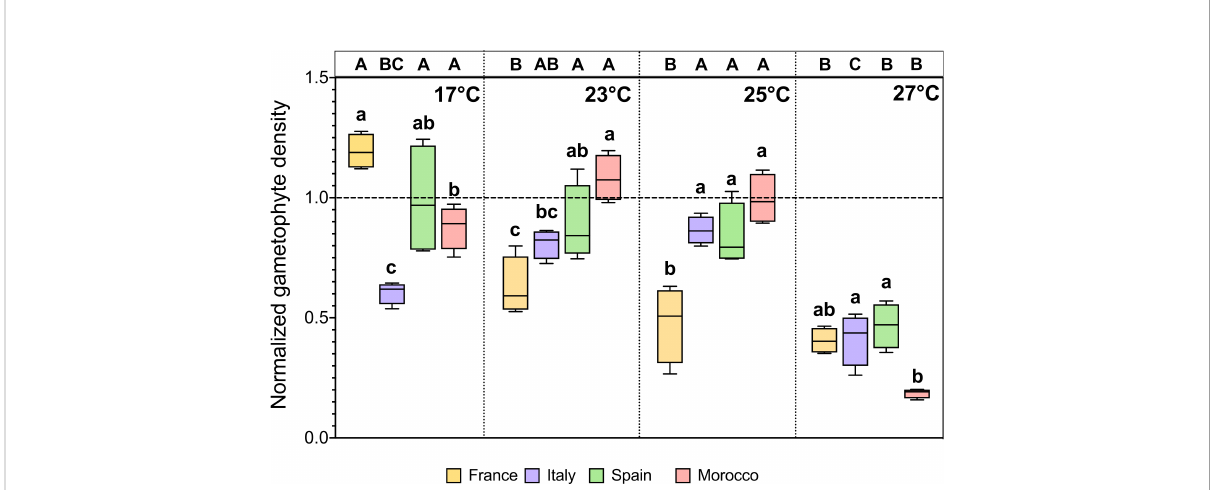
FIGURE 3 Gametophyte density from different populations (FR, IT, SP, MO) of Laminaria ochroleuca after recovery (day 38) at 17°C from different thermal treatments (17°C, 23°C, 25°C and 27°C). Note that density values were normalized to the respective initial value for each population (dotted line). Box plots with median, boxes for 25 th and 75 th percentiles and whiskers indicating min and max values (n = 4). For each temperature, different lowercase letters above boxplot bars indicate signi fi cant differences between populations. For each population, different uppercase letters indicate differences between temperatures ( p < 0.05). See Table 2 for statistical